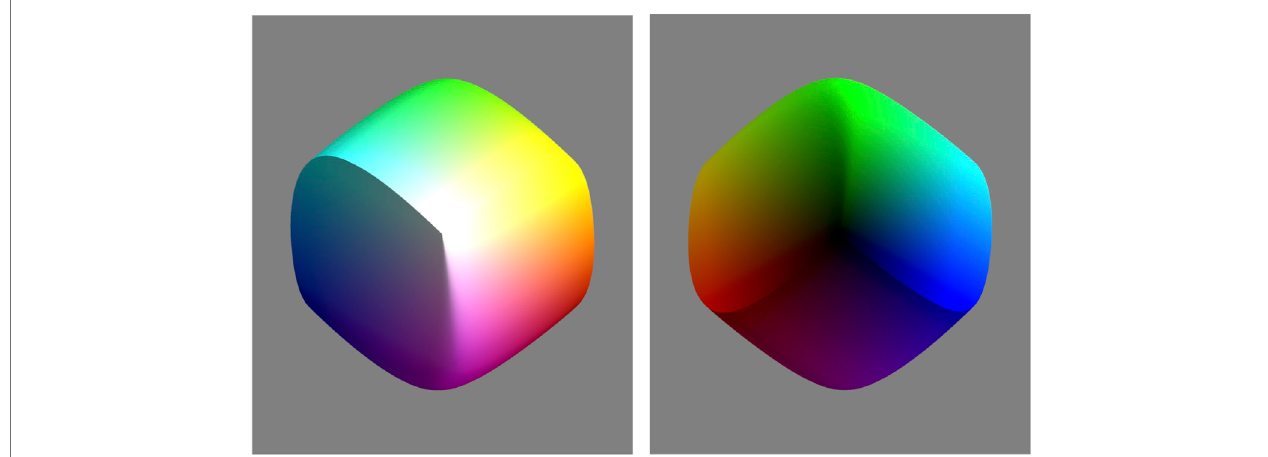
FIGURE 3 | Two views of S RGB . The display colors are simply transcribed from the coordinates (Watch it, for this will not work in C XYZ ). Conical points and dihedral edges are clearly visible.